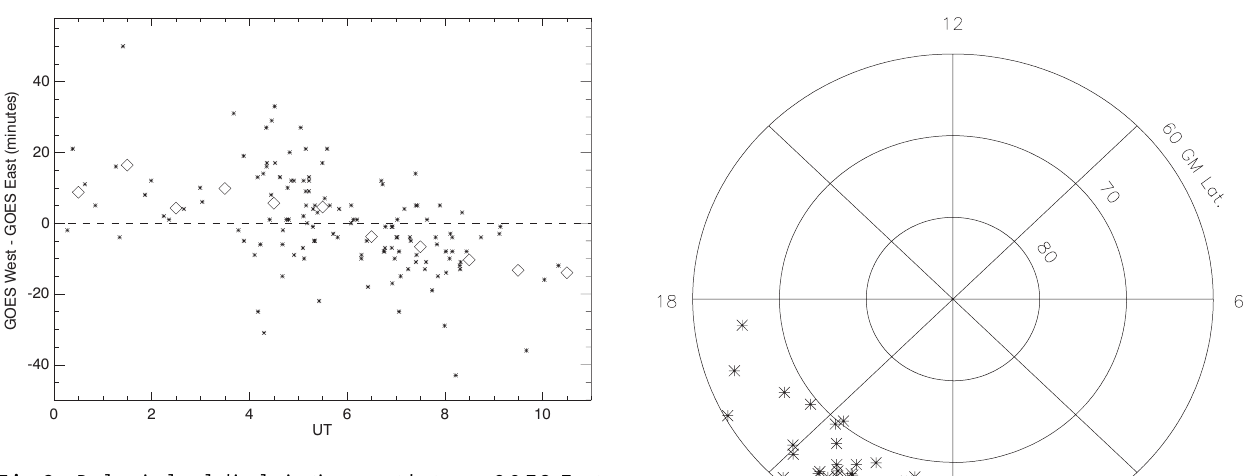
Fig. 2. Delay in local dipolarization onset between GOES East (GOES 8 or 12) and GOES west (GOES 9 or 10) for substorm on- set times. The large diamond shapes indicate 1h averages of these delays.